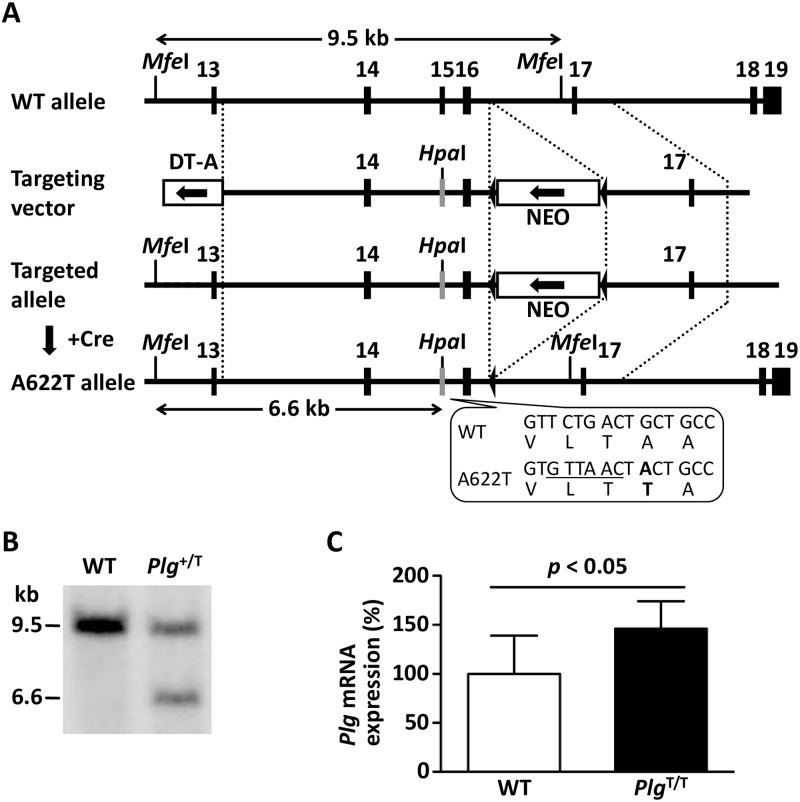
Generation of Plg-A622T mice.(A) Structure of the targeted locus in the mouse Plg gene. Exons are represented by filled boxes. A loxP-flanked (filled triangles) neomycin-resistance cassette (NEO) and a diphtheria toxin A fragment expression cassette (DT-A) are indicated by open boxes with arrows that represent the transcriptional orientation. The A622T mutant allele was produced by homologous recombination and NEO deletion mediated by Cre recombinase. The c.1864G>A (p.A622T) mutation and three translationally silent mutations (c.1857T>G, c.1858C>T, c.1860G>A) creating a new HpaI site (GTTAAC) were introduced into exon 15. Homologous fragments are indicated by dotted lines, while the MfeI-HpaI fragments detected by Southern blot analysis of the wild-type (WT) and Plg-A622T alleles are indicated by double-headed arrows. (B) Southern blot analysis. Genomic DNA from targeted ES cells was digested with MfeI/HpaI and detected with the specific probe (WT allele: 9.5 kb; Plg-A622T allele: 6.6 kb). (C) Quantitative RT-PCR analysis. Total RNA was extracted from mouse liver and subjected to real-time RT-PCR with dual-labeled probes for mouse Plg and Rn18s. Expression levels of Plg mRNA were normalized to Rn18s mRNA. Data are the means ± SDs of WT (n = 8) and PlgT/T (n = 7) mice. The levels measured in WT mice were defined as 100%.